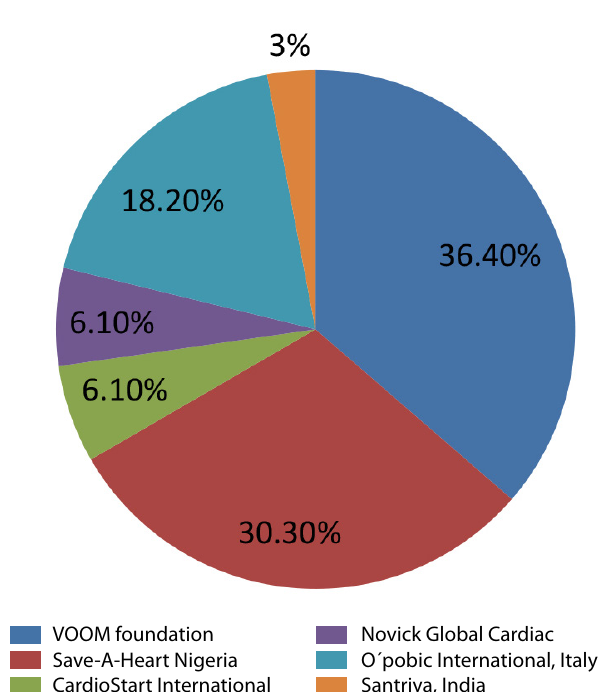
Fig. 4 - Different visiting foreign cardiac teams and number of missions (%). VOOM=Vincent Ohaju